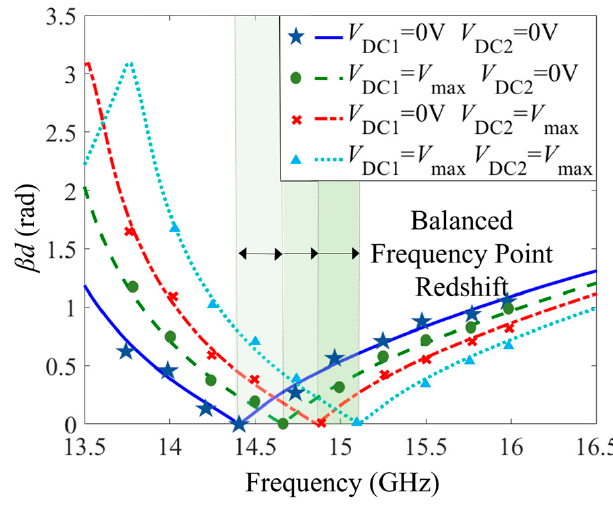
Figure 4. β d of the CRLH unit cell under dual-tuned mode of LC.